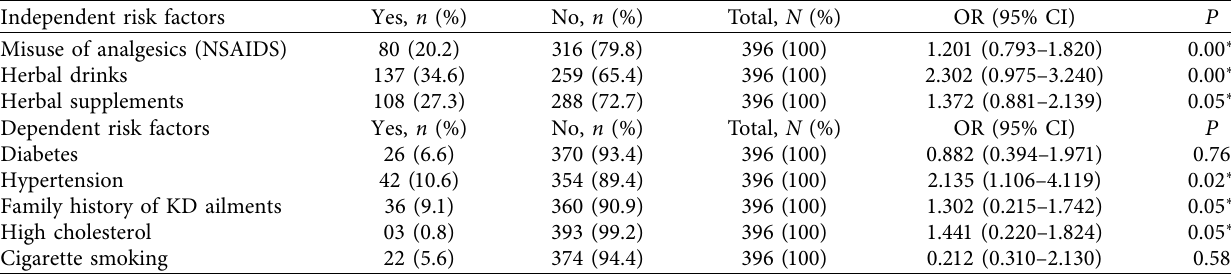
Table 3: Respondents’ self-reported risk factors for CKD, N � 396.